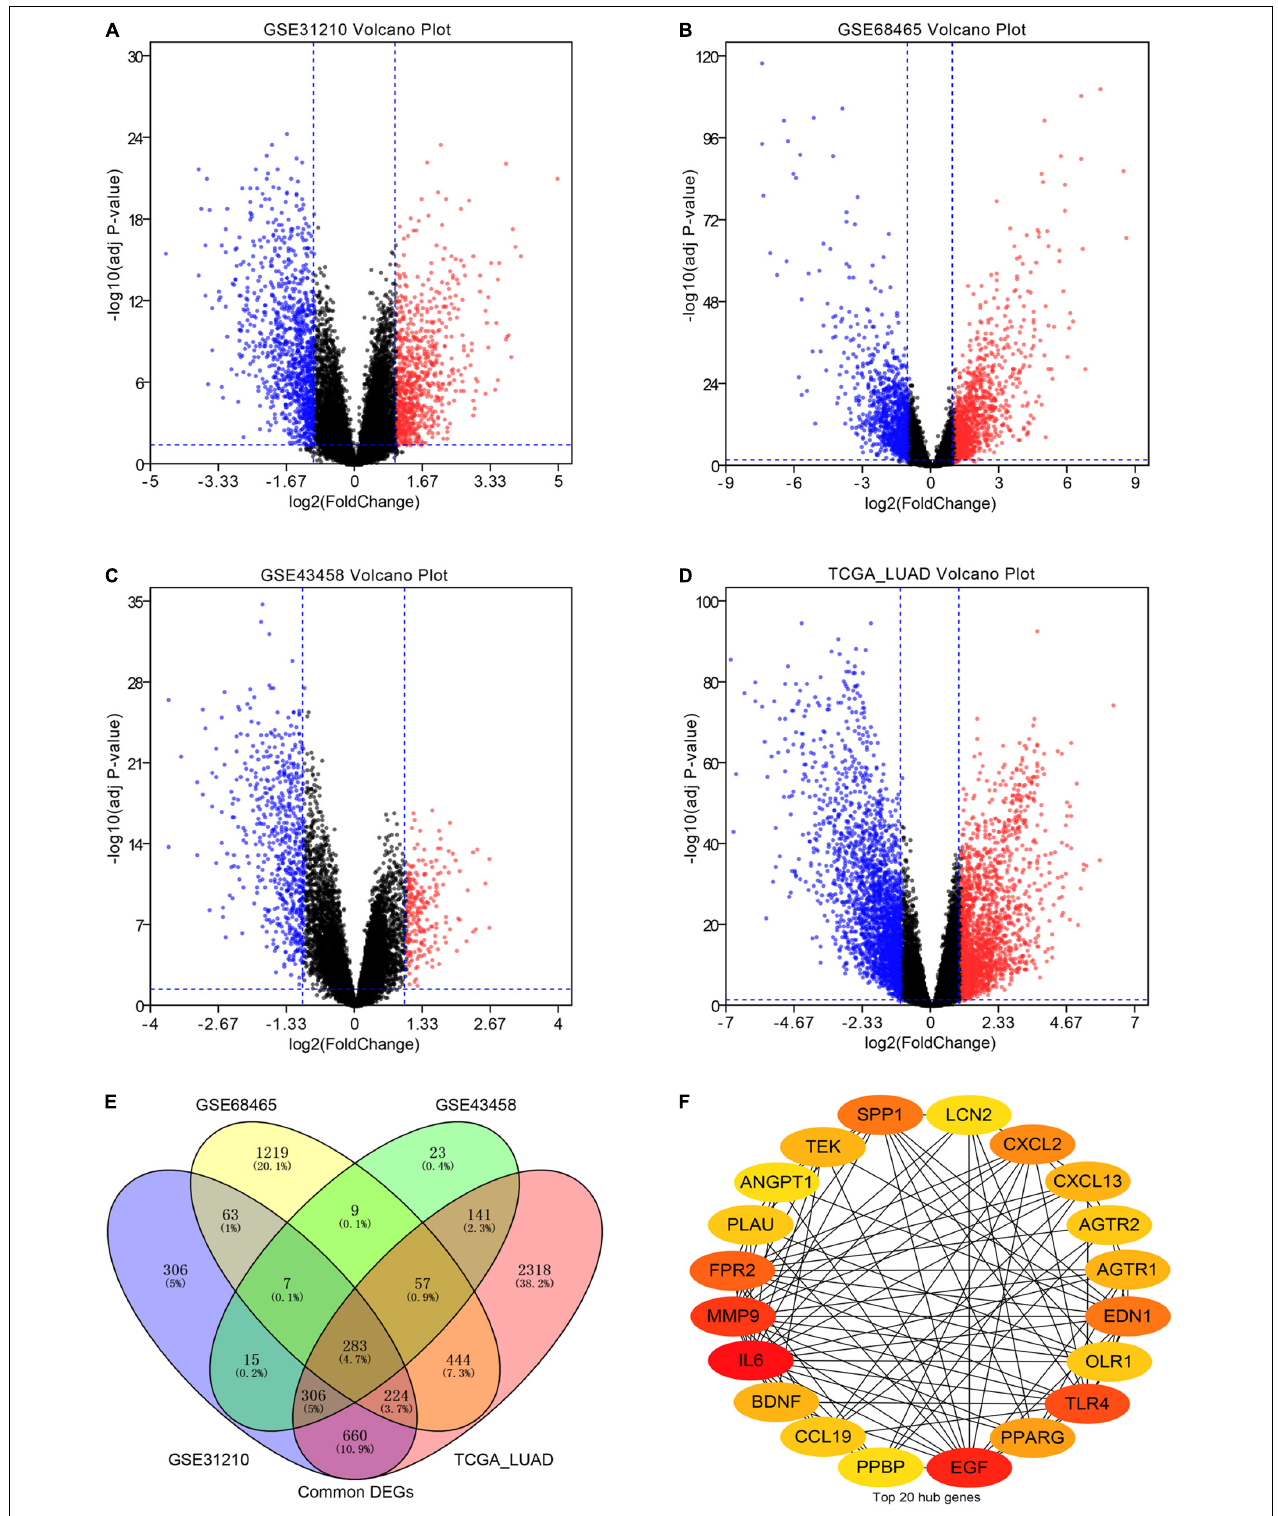
FIGURE 2 | Screening differentially expressed genes (DEGs) in our analysis. (A–D) The volcano plots of DEGs in the GSE31210 group, GSE68465 group, GSE43458 group, and TCGA_LUAD group with thresholds of | log2FC| > 1, average expression > 1, and adjust P -value < 0.05, respectively. The red dots and blue dots represent the up-regulated and down-regulated DEGs, separately. (E) The intersection of DEGs in four groups. (F) The top 20 hub immune-related genes (IRGs) in our cohort.